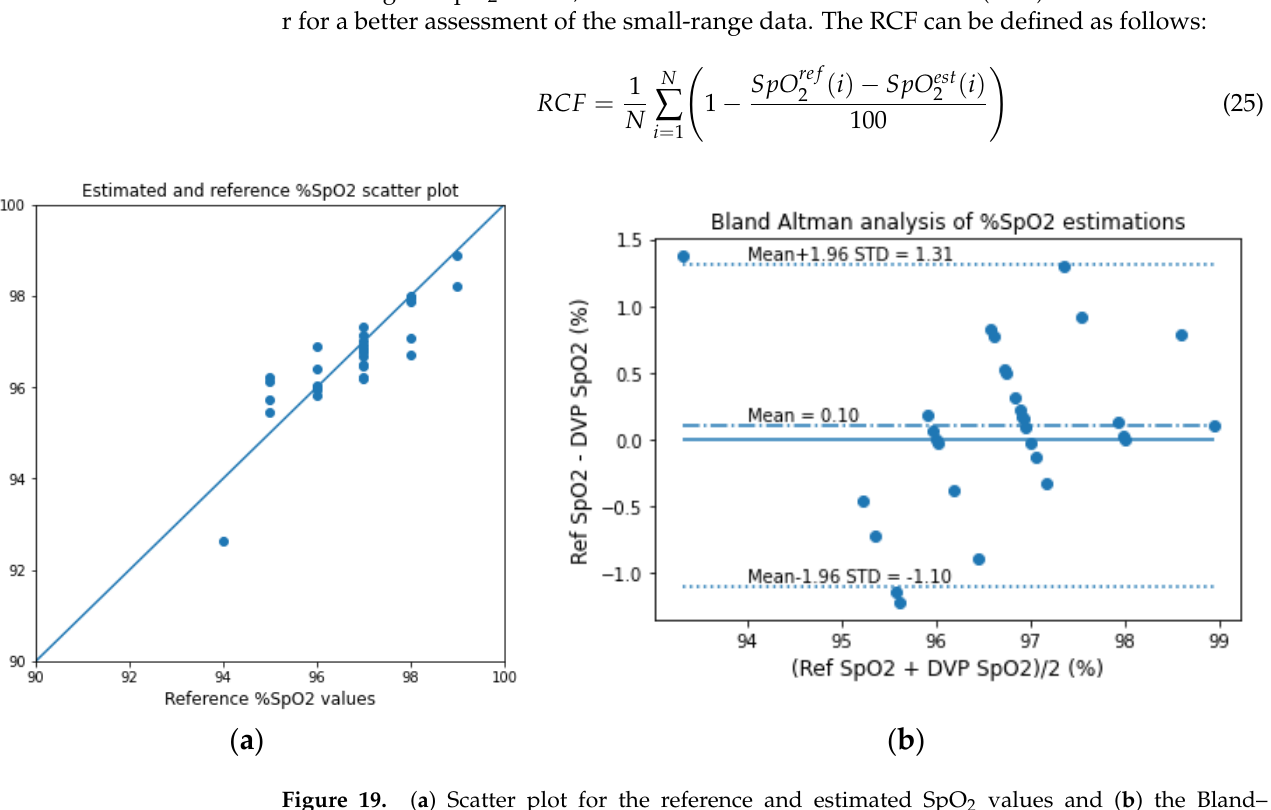
Figure 19. ( a ) Scatter plot for the reference and estimated SpO 2 values and ( b ) the Bland – Altman analysis plots of the experimentally acquired data for the transmission-type signal of the fingertip model. Table 5. Evaluation metrics of SpO 2 for the transmission-type fingertip model.